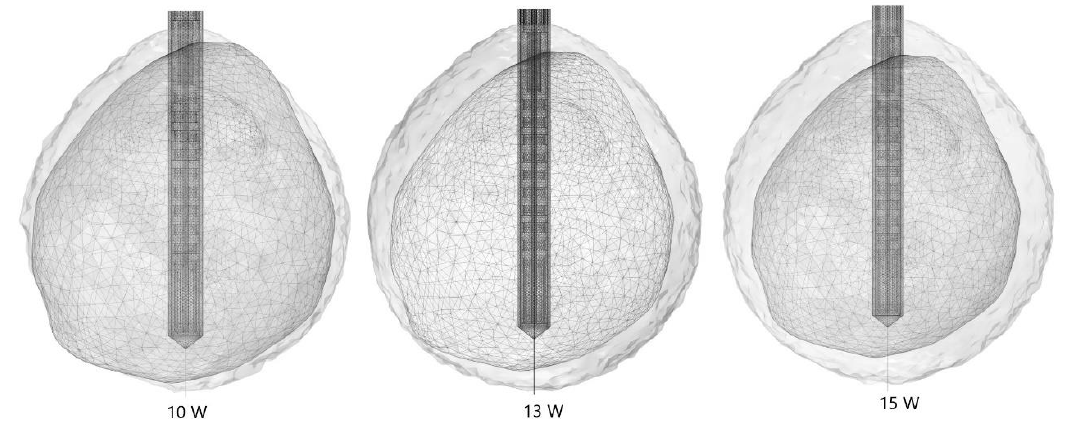
Figure 6. Isocontours represent the totally ablated regions (gray surfaces) around the liver tumor [70] (triangulated surface) exposed to 600 s of microwave ablation at 2.45 GHz and the three values of the input power (10 W, 13 W, and 15 W).